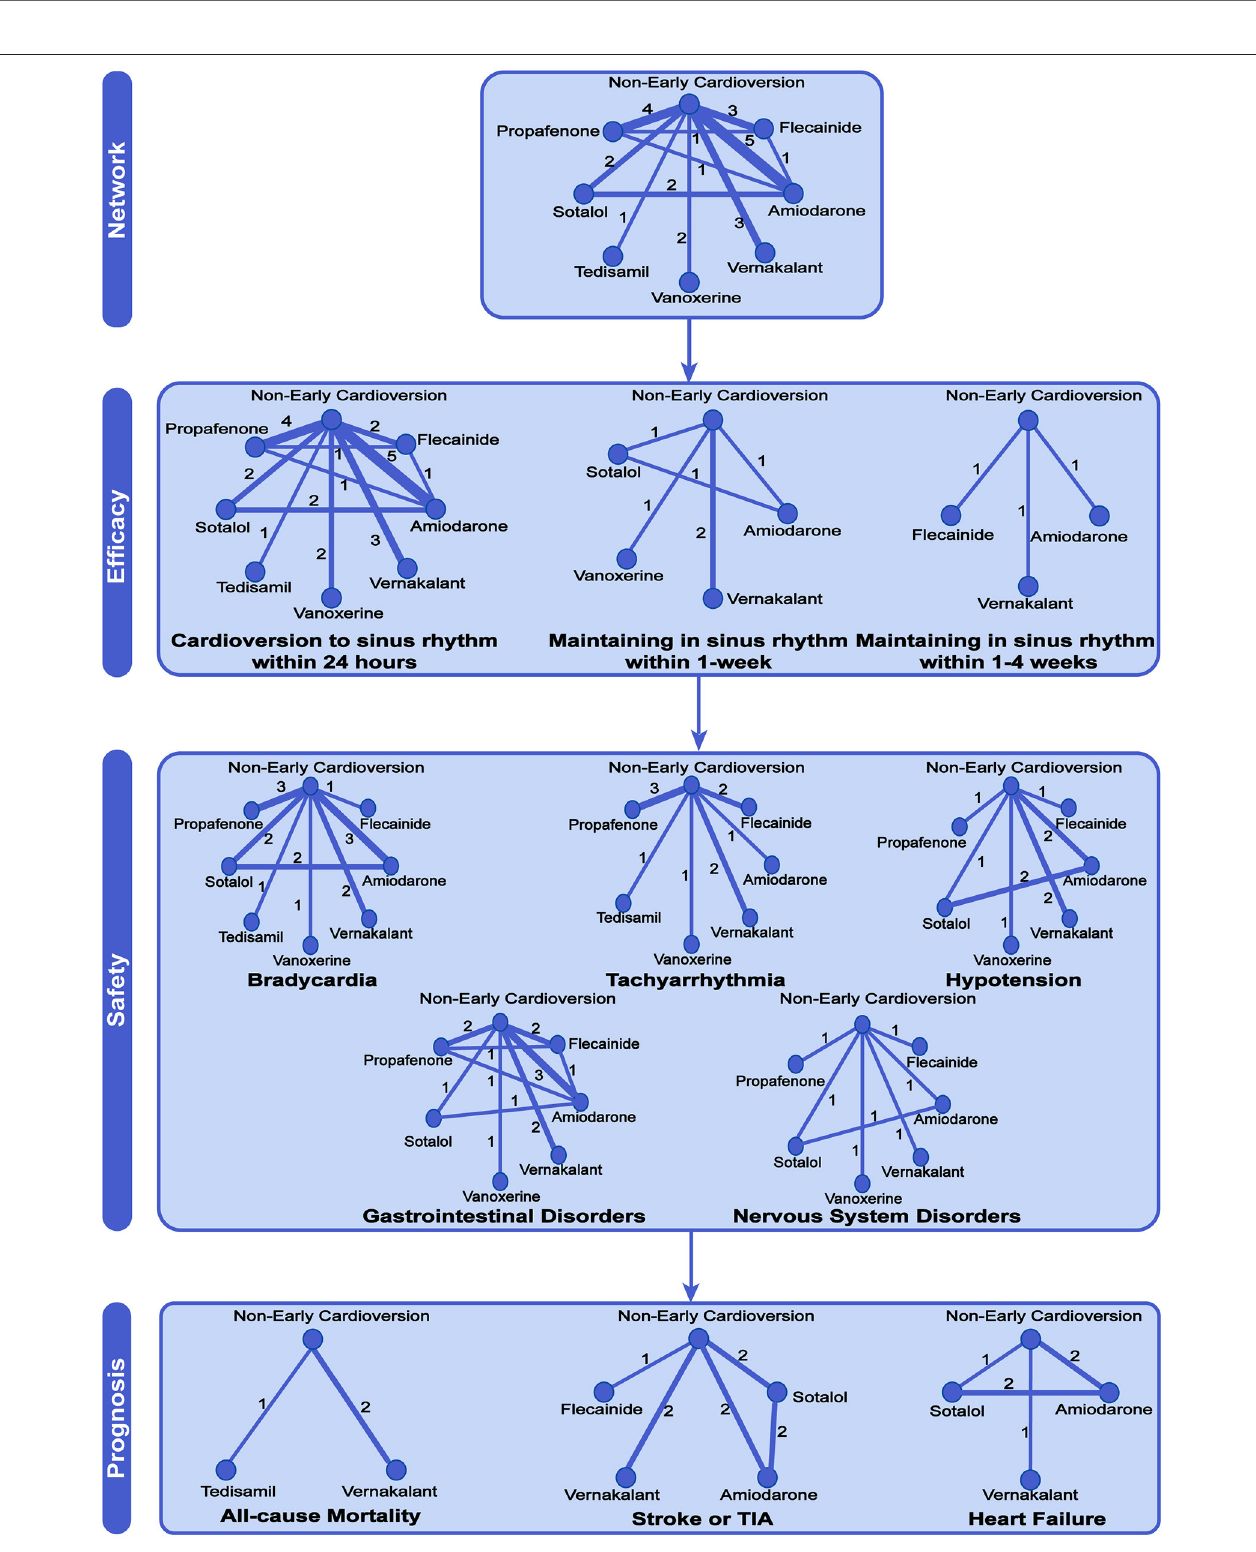
FIGURE 2 | Network meta-analysis of available comparisons. Circular nodes show different antiarrhythmic drugs as early pharmacologic cardioversion and non-early cardioversion.The antiarrhythmic drugs in the study included amiodarone, propafenone, flecainide, tedisamil, vernakalant, vanoxerine, and sotalol. Line width is proportional to the number of trials including each pair of treatments (direct comparisons). TIA, Transient Ischemic Attack.